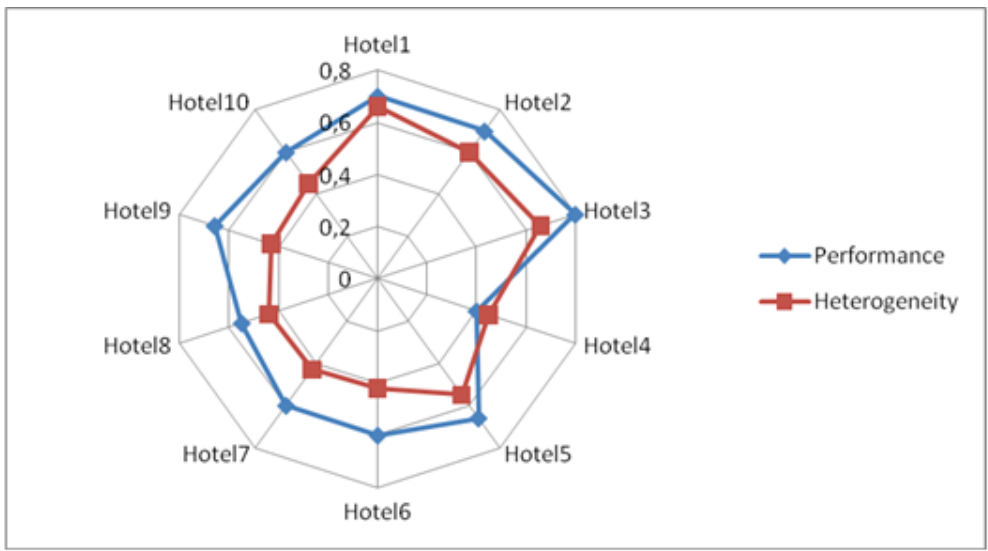
Figure 1: Overlapping of Human Capital Heterogeneity and Organizational Performance of